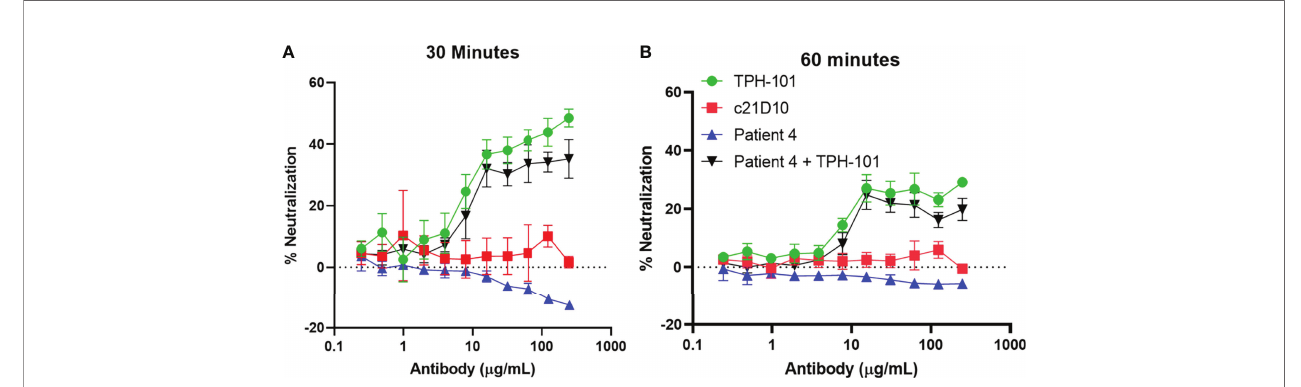
FIGURE 4 | TPH-101 complementation of anti-Gmd antibody-de fi cient human serum in vitro . The indicated concentration of puri fi ed anti-Gmd TPH-101 mAb, irrelevant control mAb (c21D10), or twofold serial dilutions of human sera that do not contain neutralizing anti-Gmd antibodies (Patient 4 in the AO-CPP cohort) was added to 10 m g/ml of recombinant Gmd prior to incubation with 0.075% heat-killed M. luteus cell wall extract in the presence of 0.5% Triton X-100 at 37°C for 30 min (A) or 60 min (B) , and the percentage of neutralization was determined as described in Figure 2 . Complementation of the patient 4 serum was also assessed by addition of TPH-101 or c21D10 at the indicated concentration. No differences in the percentage of neutralization of puri fi ed TPH-101 vs. TPH-101 in the human serum were detected at any concentration of